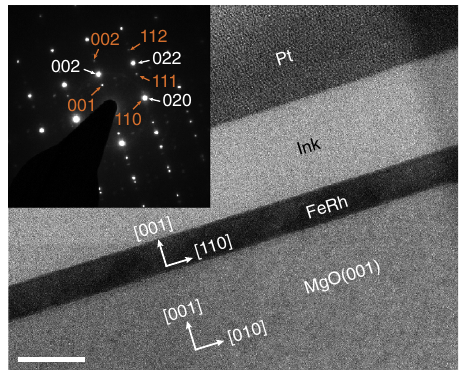
Figure 1 | Epitaxial FeRh thin film on MgO(001) substrate. Conventional TEM image (main panel) and diffraction pattern (inset) of the area studied by electron holography. The scale bar is 100nm. On the diffraction pattern, indexes in orange correspond to the FeRh layer and white ones to the MgO